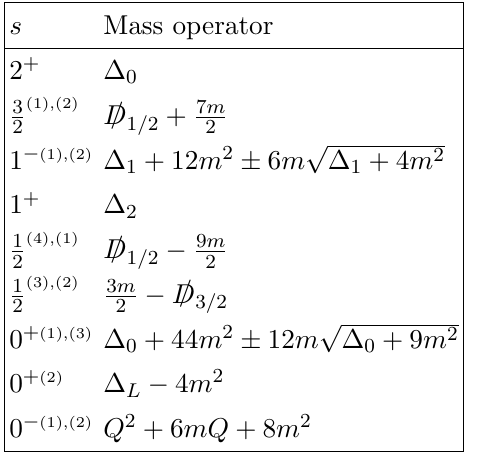
Table 2. Mass operators appearing in the Freund-Rubin compactifications. The superscript signs on bosonic fields specify its parity. For spins 1 − and 0 + the minus sign in M 2 should be selected for the superscript (1) and the plus sign for the second superscript. For spins 3 , 1 and 0 − the first 2 2 superscript corresponds to the negative part of the spectrum of the linear operator in question (i.e., /D /D 1 / 2 , 3 / 2 and Q ) while the second label corresponds to the positive part of the spectrum. The AdS 4 irreps were combined into = 1 multiplets by Heidenreich [19] and into N = 8 multiplets by Freedman and Nicolai [4] (see also the review by Nicolai [20]). These N results are implicit in the discussions in the following